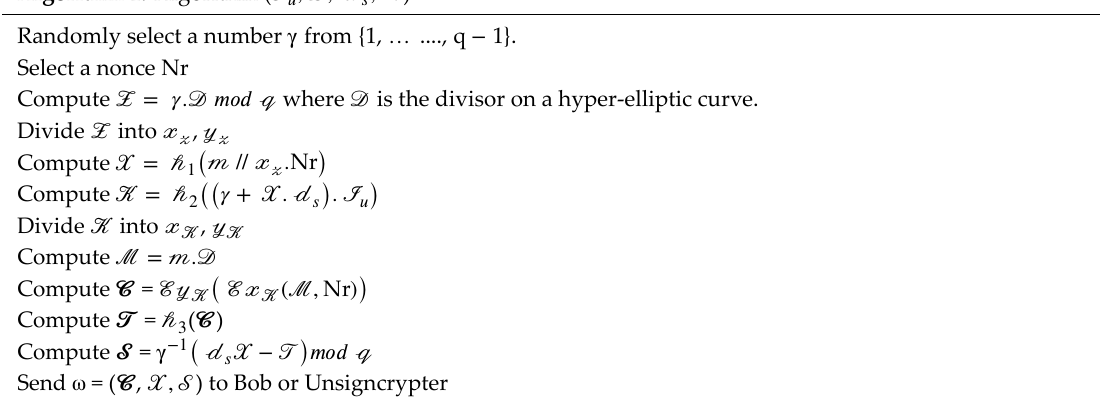
Algorithm 1. Algorithm ( ℐ 𝒖 , 𝒟, 𝒹 𝒔 , 𝓂 )